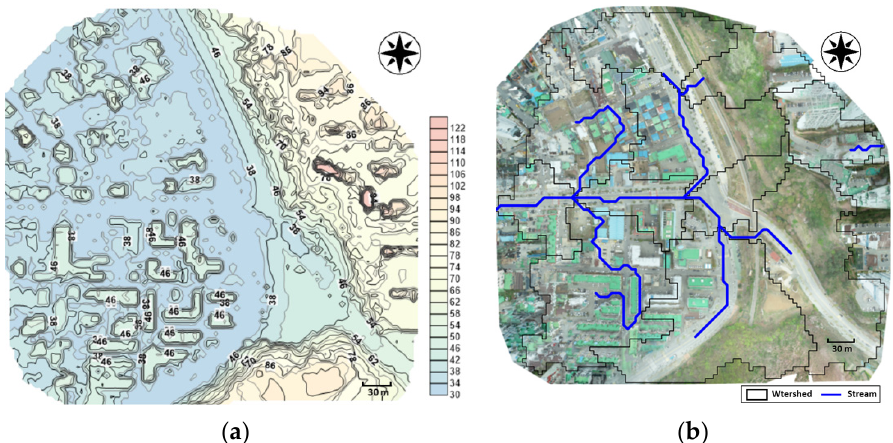
Figure 11. Watershed analysis using topographic data of UAV. ( a ) Contour; ( b ) watershed.